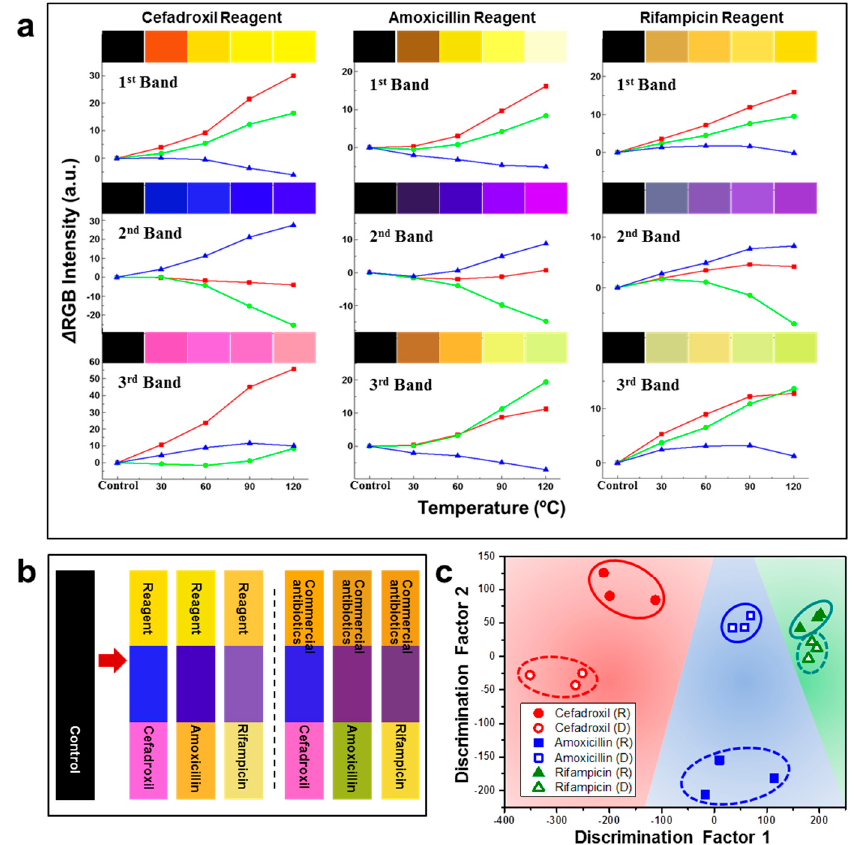
Figure 11. Measurement of various antibiotics using M13 bacteriophage-based color sensors. ( a ) Sensitivity measurement at different temperatures using fixed amount of samples, ( b ) color change translation of samples, and ( c ) PCA analysis of antibiotic sensing. Reproduced from [69], with permission from Wiley-VCH, 2016.